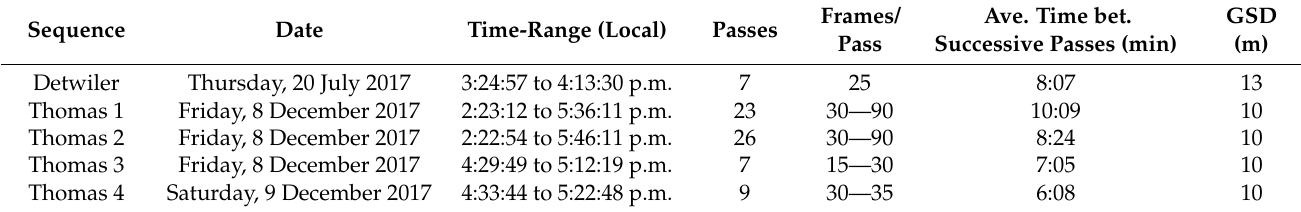
Table 1. Airborne thermal infrared imagery metadata by study fire and image